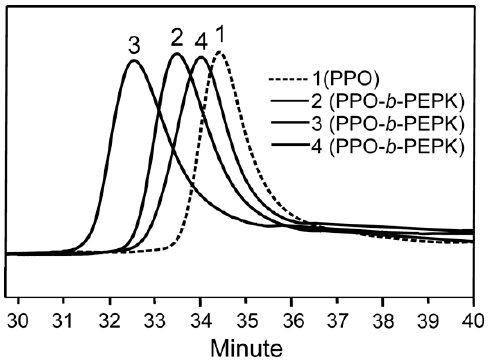
Figure 5. GPC traces of sample 1 (PPO, dashed line) and sample 2 , 3 , 4 (PPO- b -PEPK, solid lines) of Table 1.